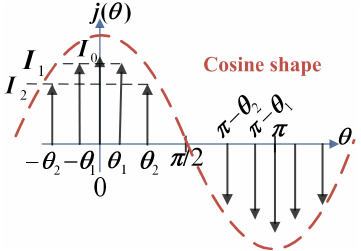
Figure 3. Illustration of the space current density distribution for non-identical currents flowing through the